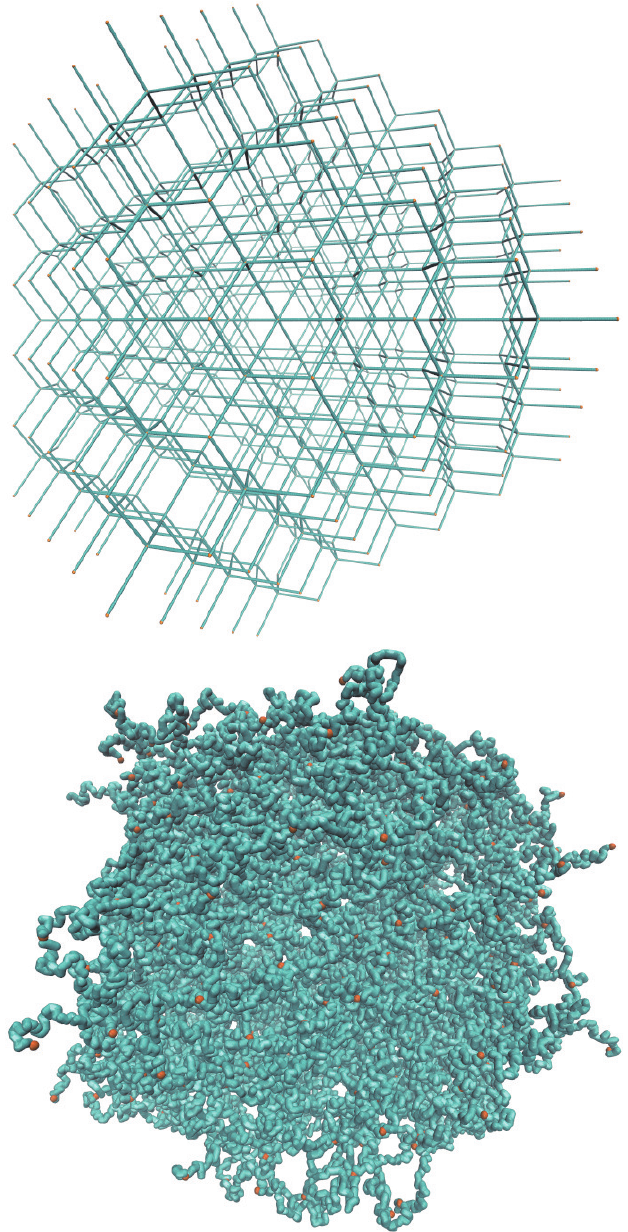
Figure 1. Topological structure of a microgel particle with N N = 40 monomers per polymer. ( Top ) Initial state with fully stretched polymers; ( bottom ) m = 0 under good solvent conditions. Cross-link monomers are equilibrated structure for l D indicated in